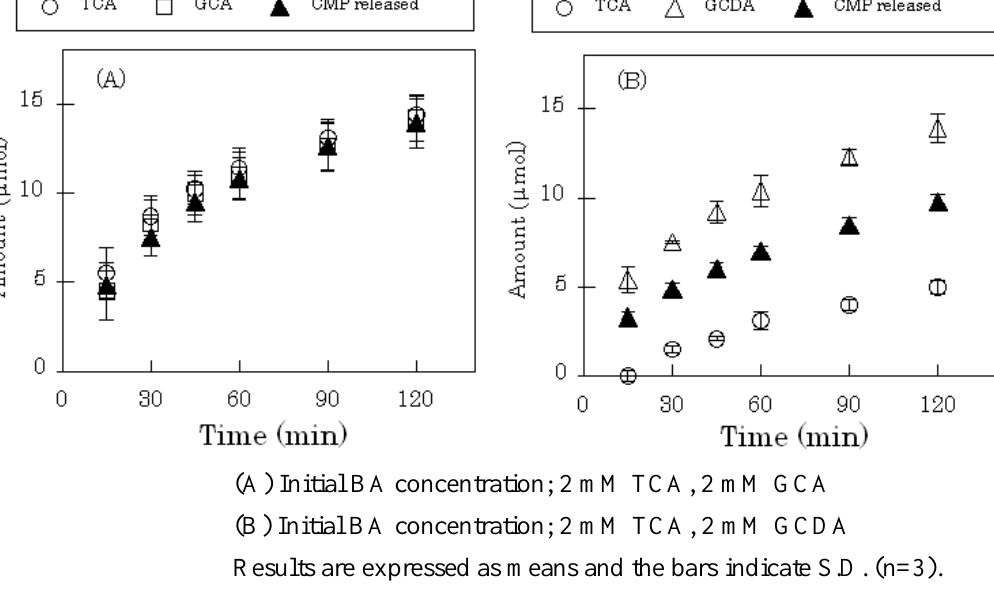
Results are expressed as means and the bars indicate S.D.